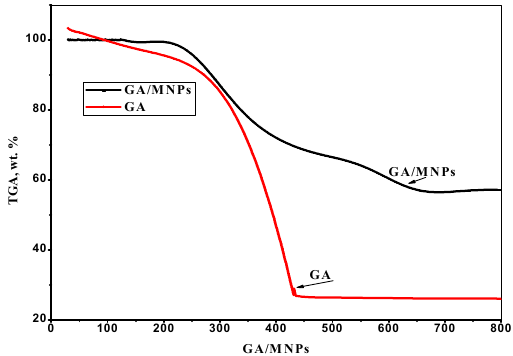
Figure 5. TGA analyses for GA and GA/MNPs.